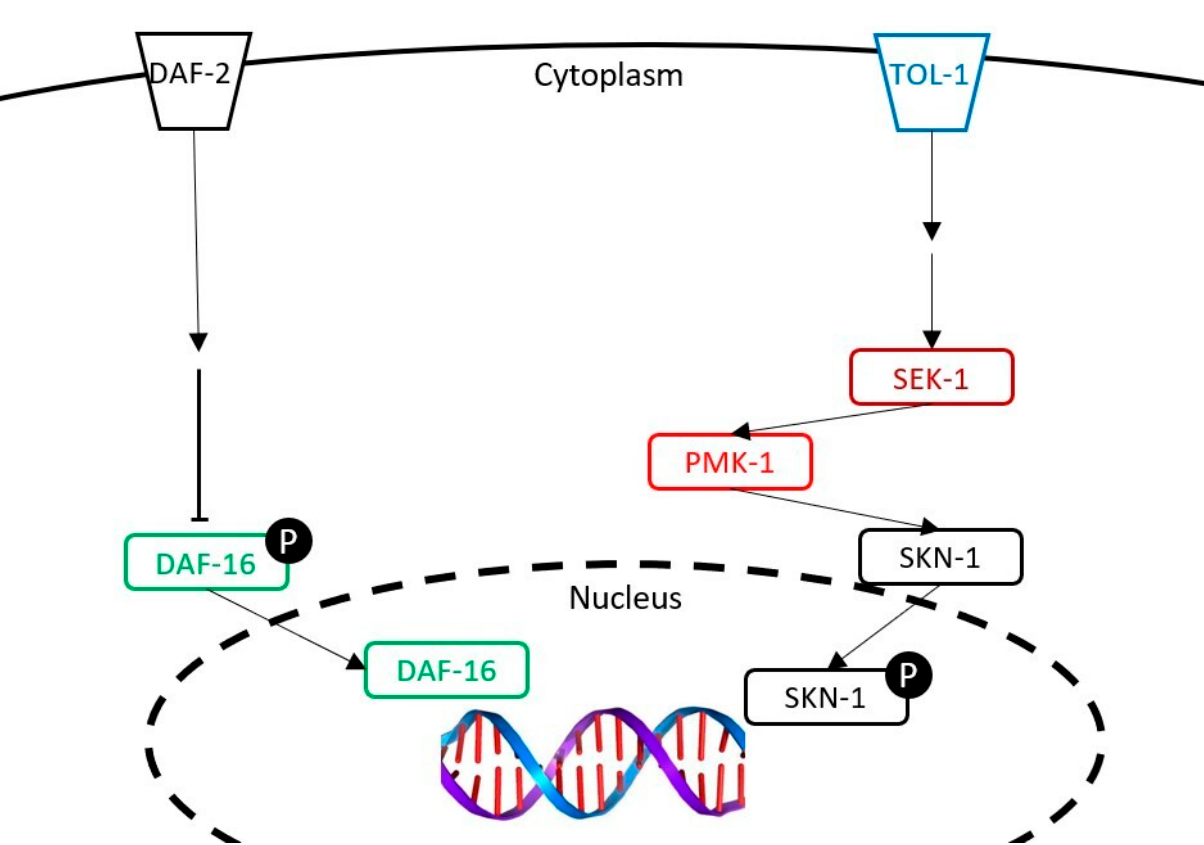
Figure 8. The representation of the insulin-like pathway and the p38 MAPK pathway studied in this article. The following genes were tested: daf -16 (studied with a mutant and a transcriptomic analysis), tol -1 (studied with a mutant), and pmk -1 and sek -1 (studied with a transcriptomic analysis). Table 5. The relative expression of the three C. elegans genes of interest after 3 days or 10 days